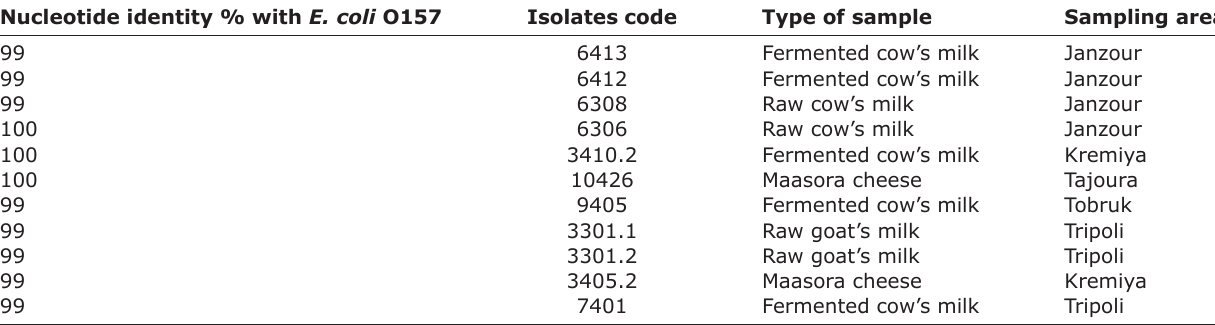
Table-2: Identification of suspected EHEC by PCR and partial sequencing of 16S rDNA. Nucleotide identity % with E. coli O157 Isolates